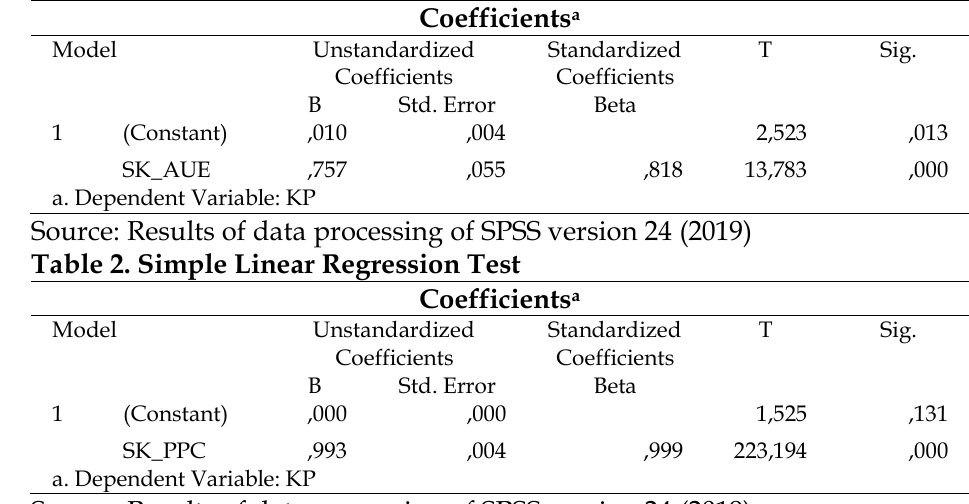
Table 1. Simple Linear Regression Test